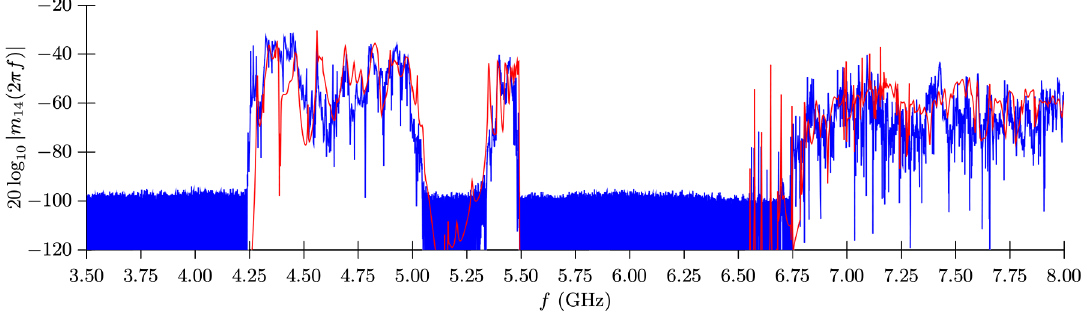
FIG. 14. Absolute value of the transmission spectra via cavity 1 and cavity 2 (i.e. transmission from coupler C1H2 to C2H2). Blue shows the measured spectrum and red the simulated. The fundamental band is not observable in the spectra because the frequencies of the respective peaks are below the fundamental cutoff frequency f bellows.